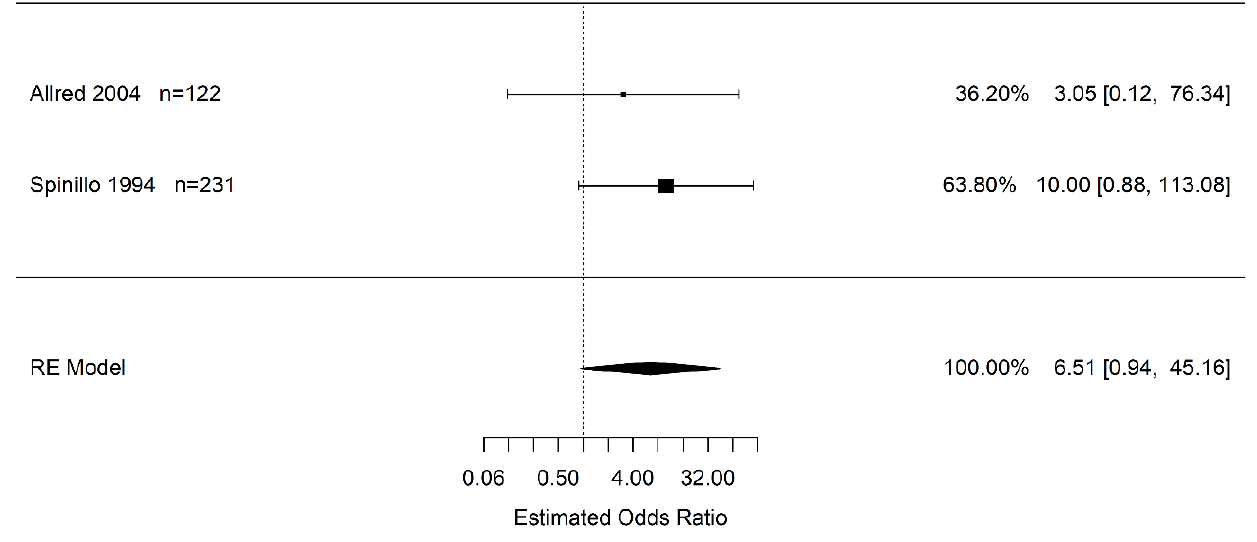
Figure 4. Estimate odds ratio of placental abruption (vs. “controls”) for intraventricular hemorrhage (any grade) calculated using random effects (RE) model [45,50].